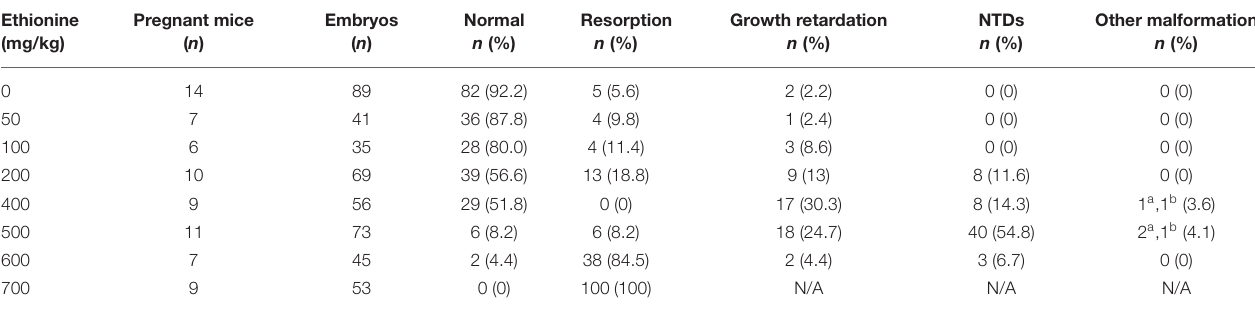
TABLE 1 | Embryonic phenotypes of mice treated with ethionine. Ethionine (mg/kg)